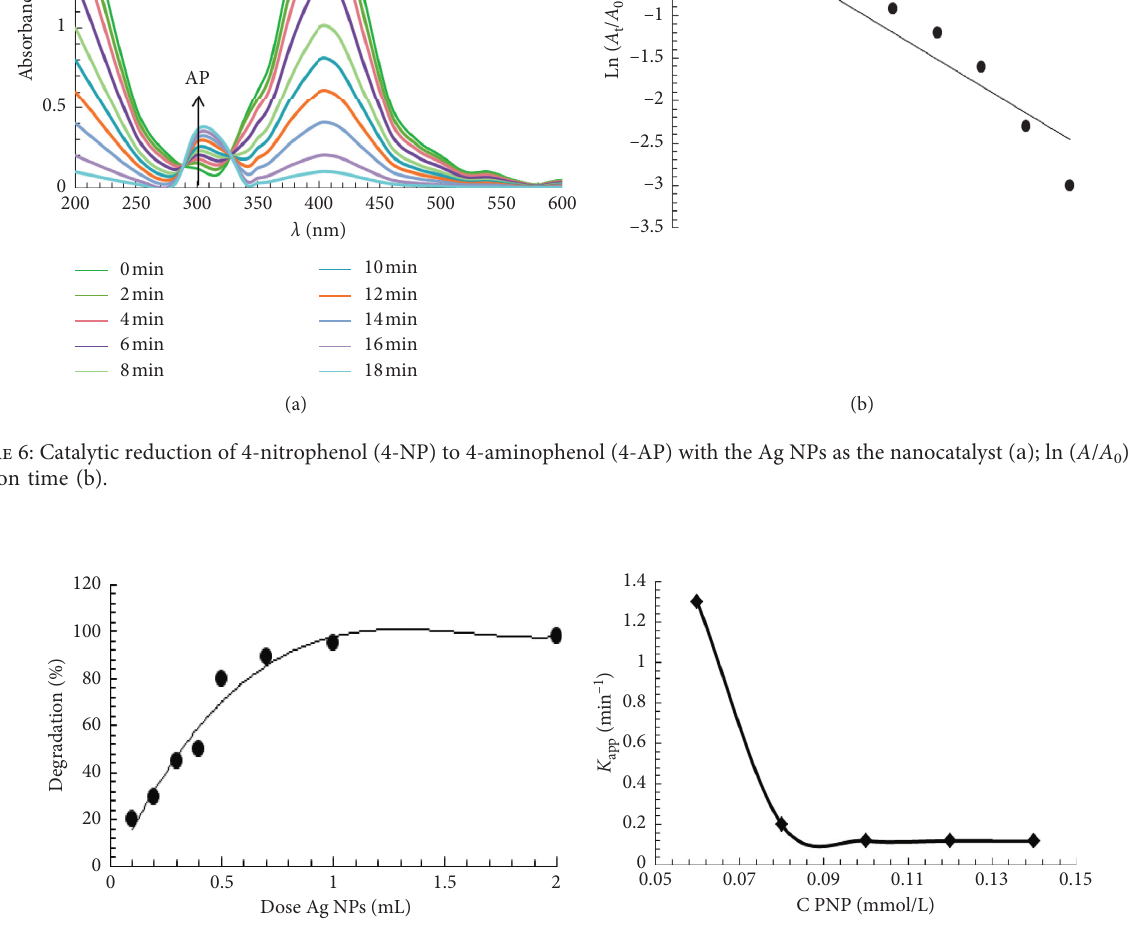
Figure 7: Effects of catalyst dosage (a) and concentration of PNP (b) on the catalytic performances.